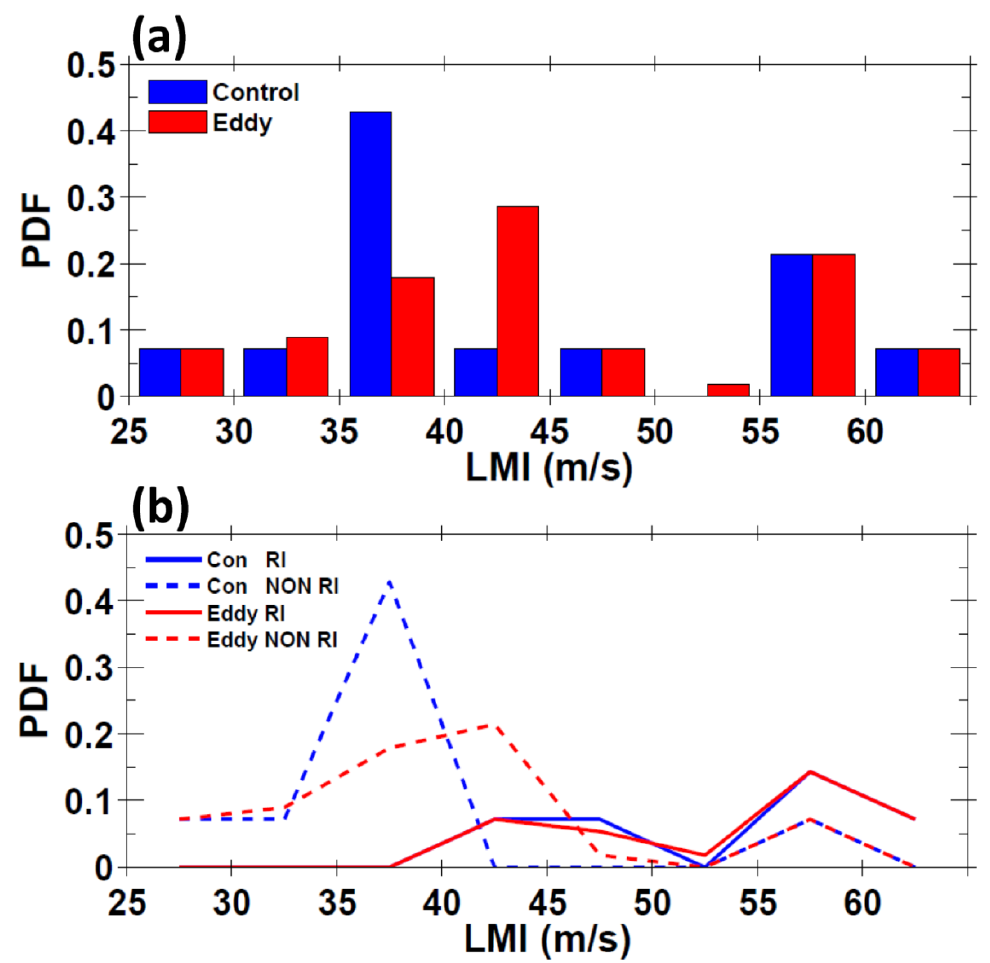
Figure 6. ( a ) The probability density functions grouped in lifetime maximum intensity, PDF, of control (blue) and eddy (red) experiments. ( b ) The PDFs of storms undergo RI at least once (solid) and that have no RI (dash) for the Control (blue) and eddy (red) experiments. (Note that parts of the blue solid line coincide with and are covered by the red solid line. For reference: major storms of Category 3 (Saffir-Simpson scale) and above have wind speeds ≥ 50 m/s).